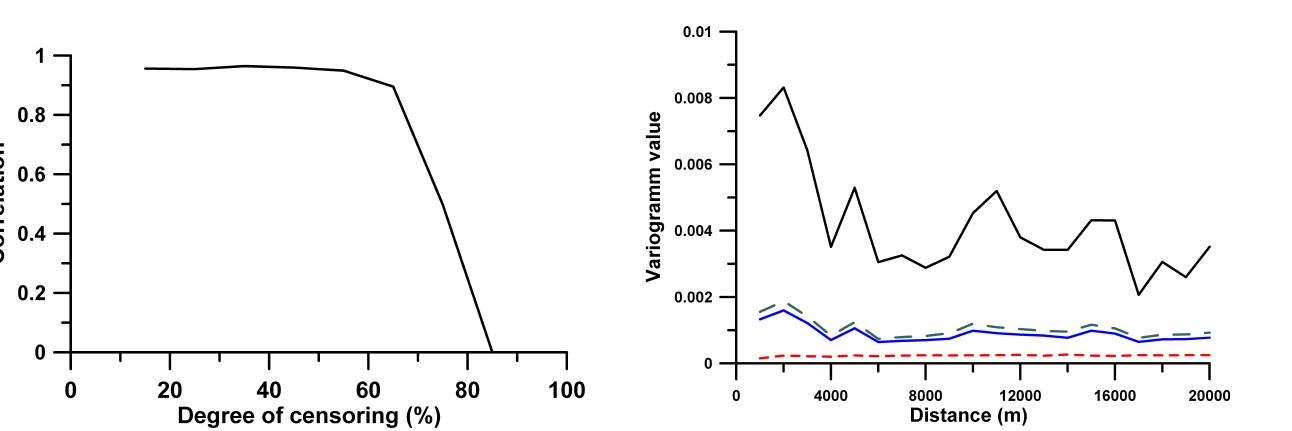
Fig. 6. Empirical variograms calculated for deethylatrasine, using exact data only (black solid), using nondetects replaced by zero (blue dashed) or by the detection limit (blue solid) and using non- detects replaced by zero and removal of outliers (red dashed).